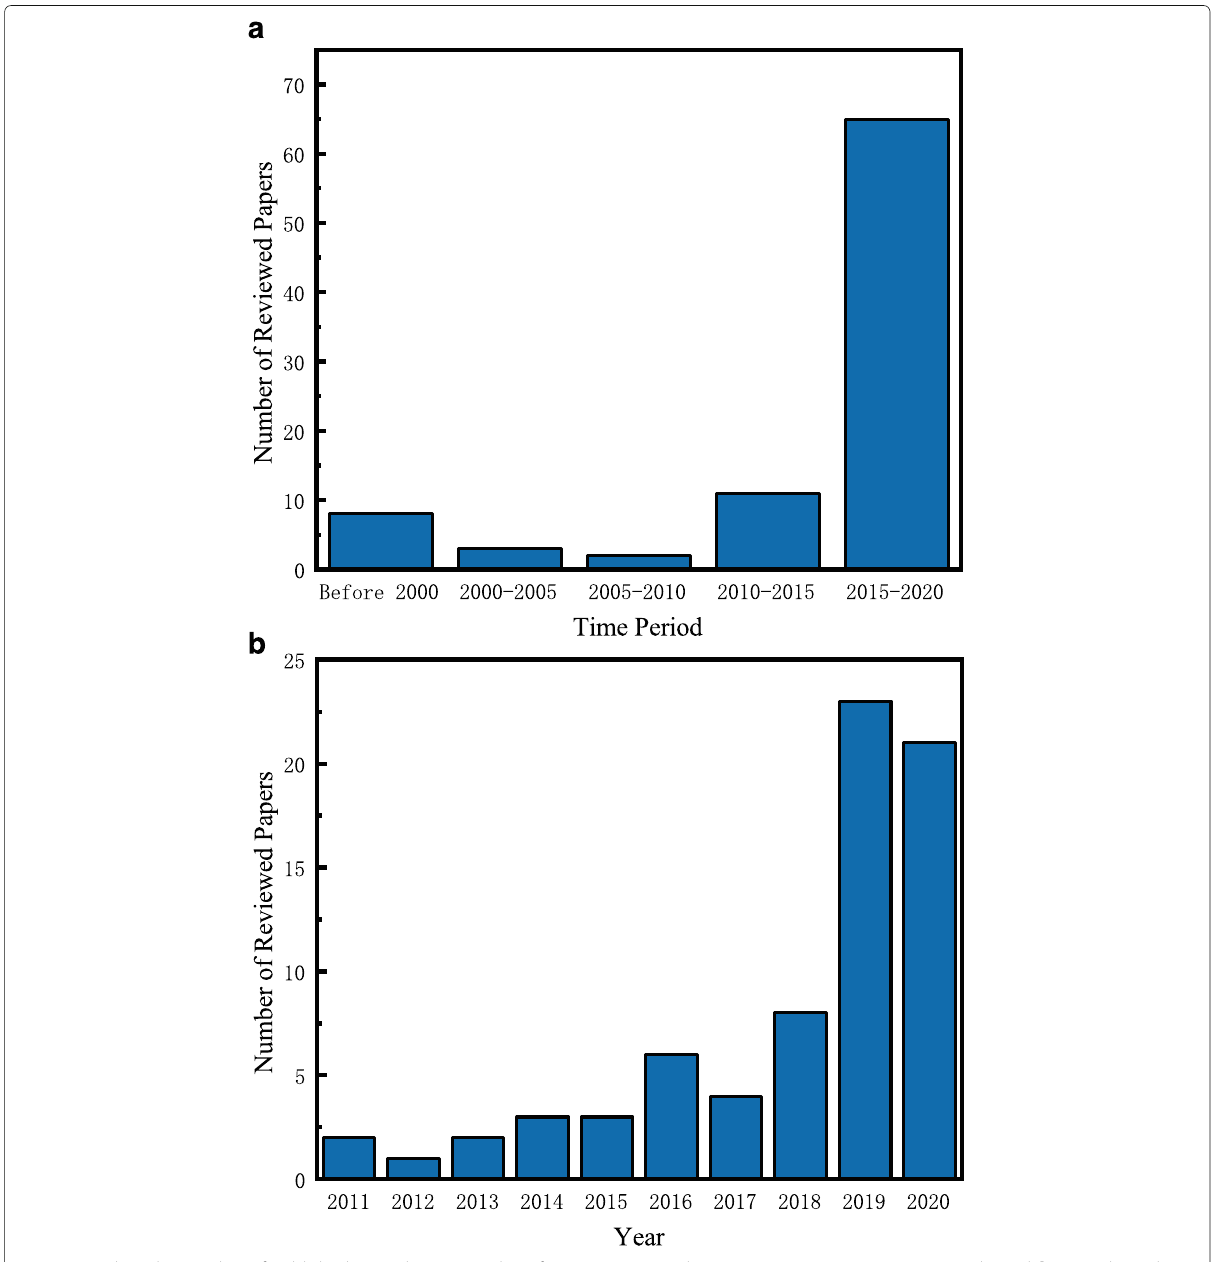
Fig. 7 Trends in the number of published journal papers and conference papers in the present review. a Ten years period trend; b Annual trend from 2010 to